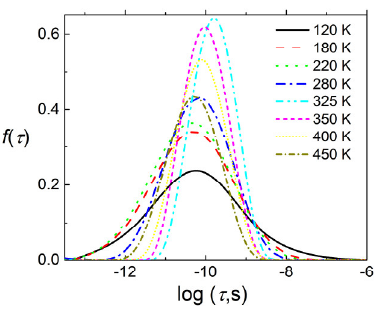
Figure 5. Distributions of relaxation times for BCT ceramics.